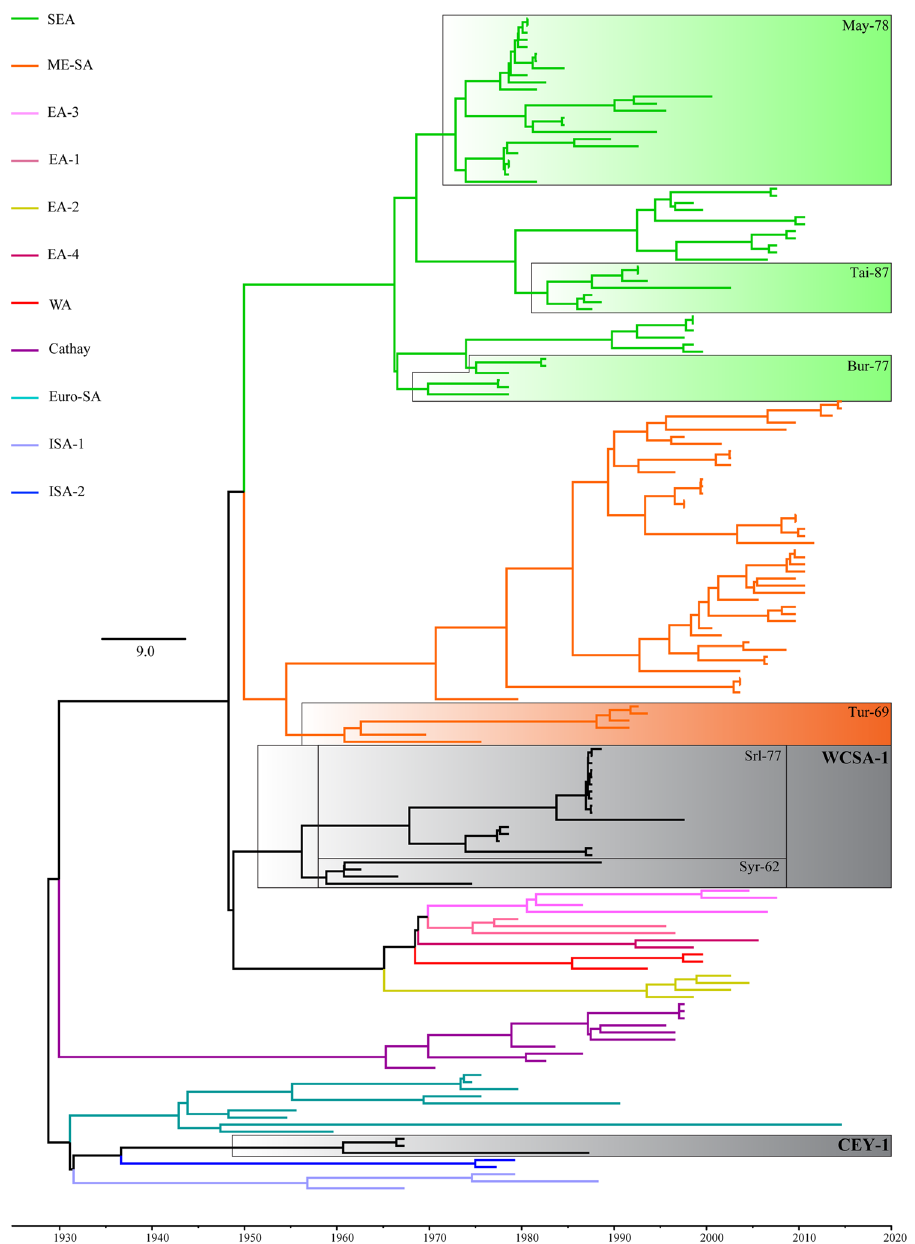
Figure 2. The midpoint rooted MCC tree showing the divergence times of the topotypes and lineages in serotype O. The X-axis represents the time scale. The scale bar indicates the rate of substitutions per site per year. The colored lines except for the black ones within the tree indicate the known topotypes as depicted in the legend. The shaded boxes indicate the novel topotypes and the novel lineages. The exact midpoint rooted MCC tree showing the divergence times with tip labels, node support (Posterior Probabilities and bootstrap values) and 95% Highest Posterior Density node bars is given as Fig.